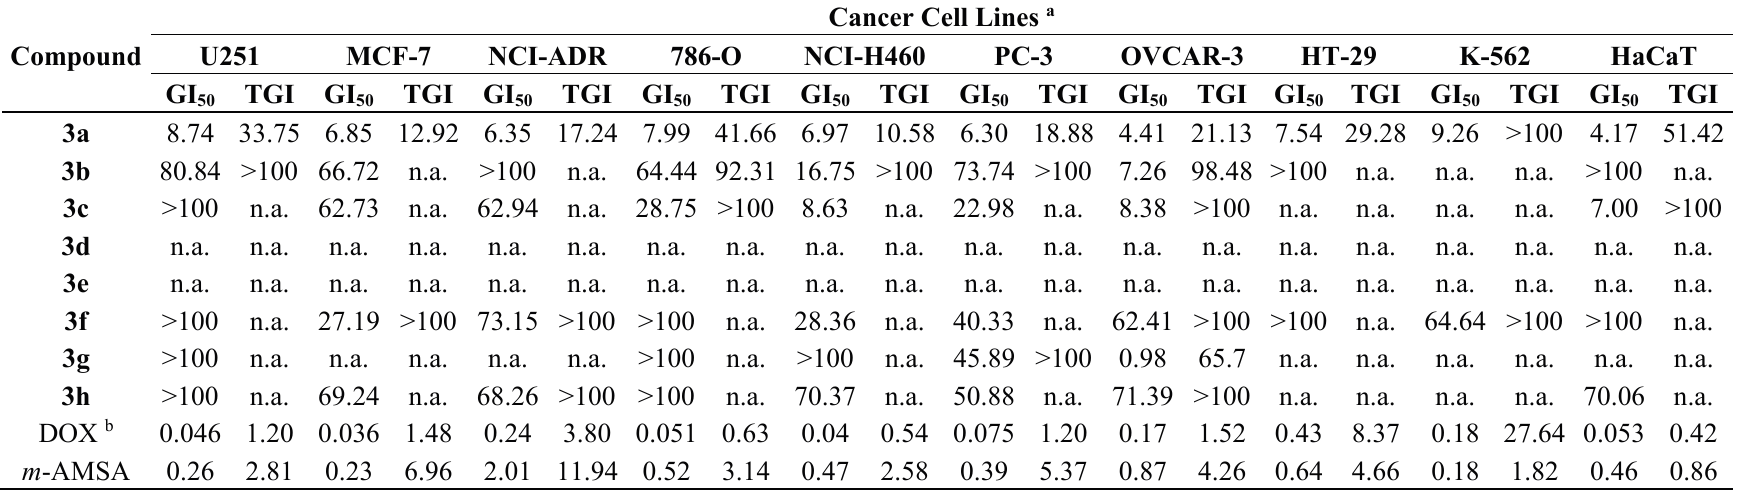
Table 2. GI 50 and TGI (in µM) values for tested compounds 3a – h , doxorubicin (DOX) and amsacrine ( m -AMSA) as positive controls.